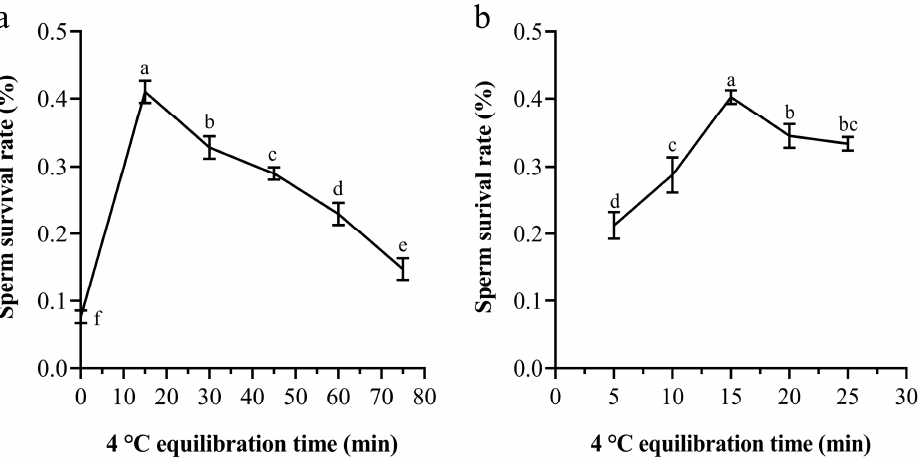
Figure 3. Survival rates of sperm of P. trituberculatus after different equilibration times. ( a ) Survival rates of sperm after 0, 10, 20, 30, 40, 50, 60, 70, and 80 min. ( b ) The survival rate of sperm after 5, 10, 15, 20, and 25 min. The same letter means that the difference is not significant ( p > 0.05), and different letters mean that the difference is significant ( p < 0.05) ( n = 60).